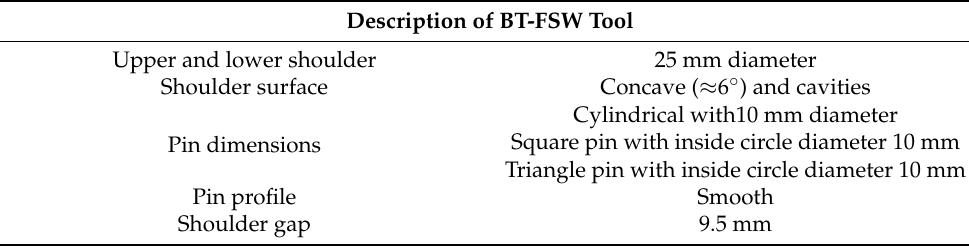
Figure 1. ( a ) Exploded 3D drawings, ( b ) dimensions, and ( c ) schematic drawings of bobbin tool [9]. (unit: mm). Table 1. Bobbin tool friction stir welding (BT-FSW) tools’ specifications